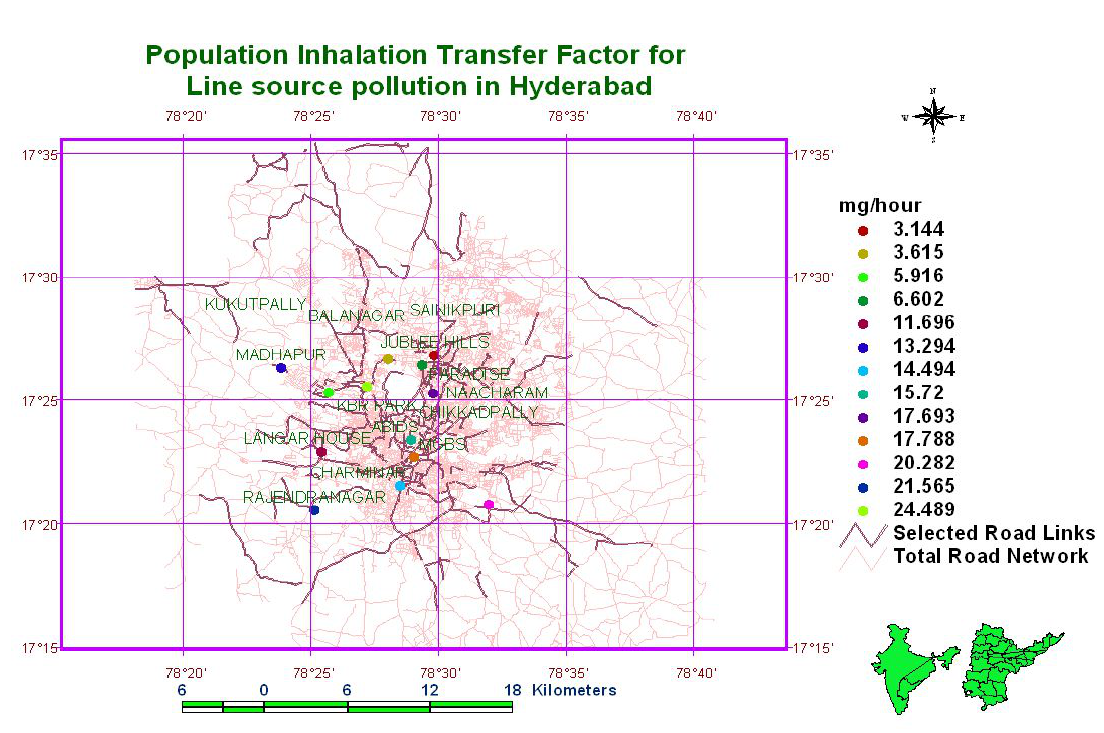
Figure 12: Population inhalation transfer factor for line source pollution in Hyderabad for year 2004